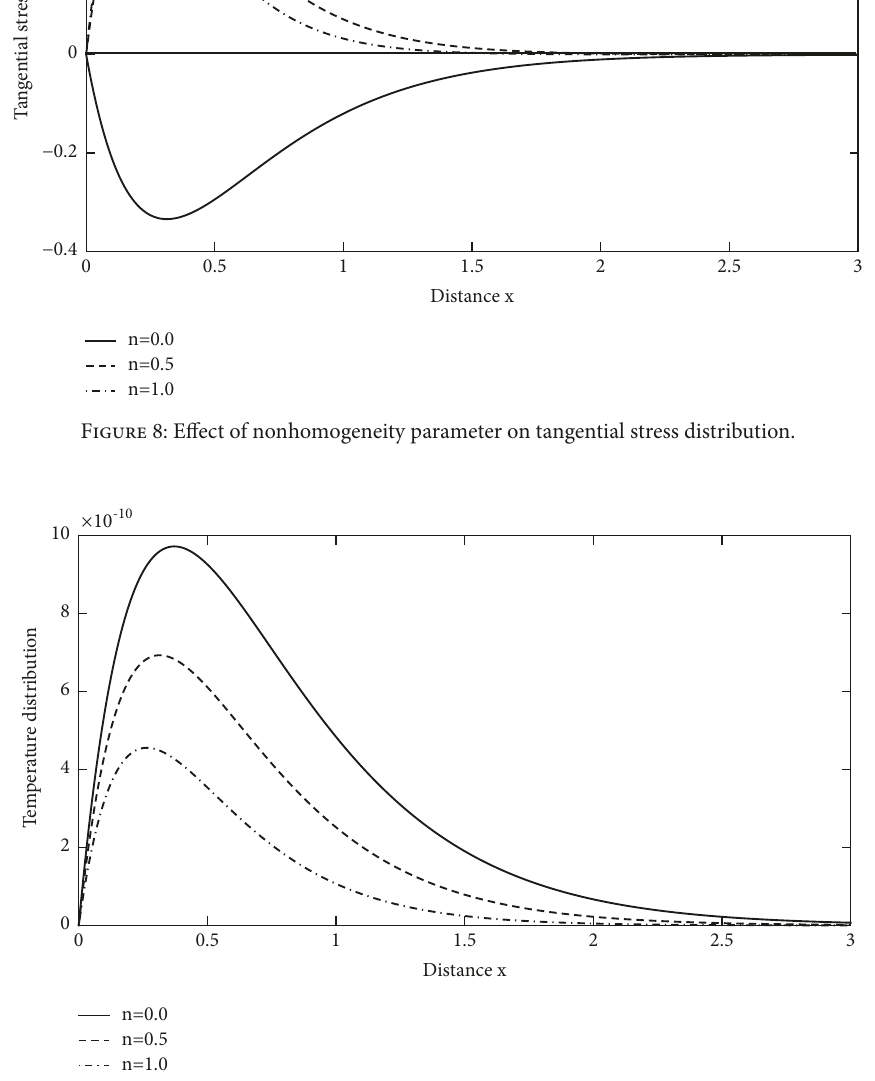
Figure 9: Effect of nonhomogeneity parameter on temperature